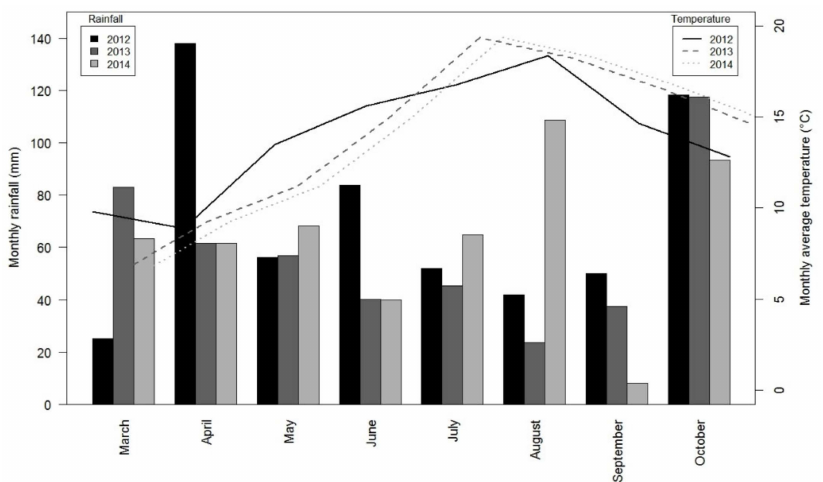
Figure 2. Monthly rainfall and mean air temperature from March-October for the 3 years of the